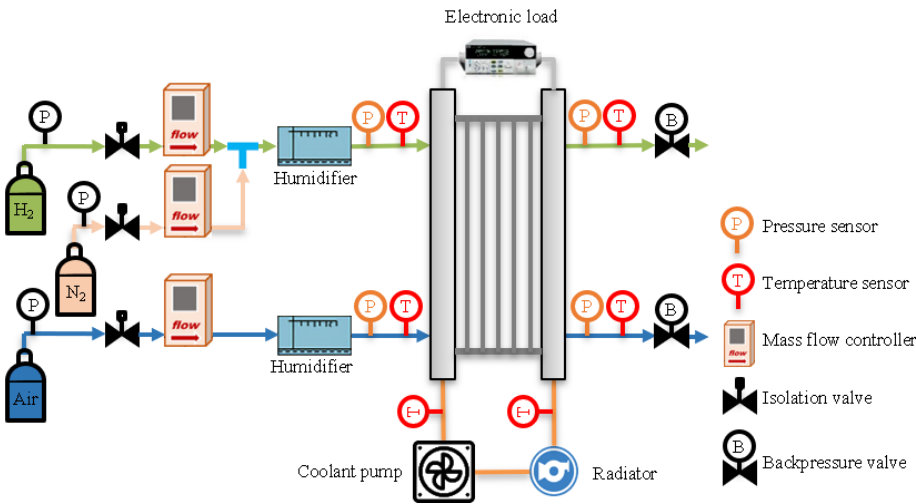
Figure 1. The schematic diagram of the experimental setup.